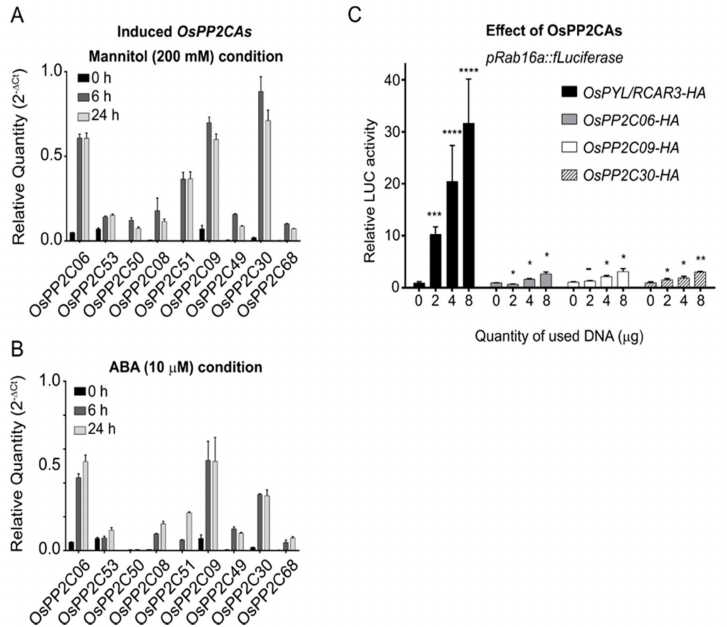
Figure 2. Highly expressed PP2CAs in the A30 line activate transcription from the Rab16A promoter. ( A , B ), relative transcript levels of 9 PP2CA genes after exposure of A30 seedlings to 200 mM Mannitol or 10 µ M ABA for 0, 6, or 24 h. All values were determined by RT-qPCR and normalized to UBIQUTIN5 levels. Error bars are means ± SD ( n = 3). Similar results were obtained in three iterations. ( C ), Effects associated with overexpression of selected OsPP2C genes on Rab16 promoter activity ( pRab16A:fLUC and pUbi:rLUC ) introduced into rice protoplasts by PEG transfection. After a 15 h incubation, luciferase activities were detected. All values were normalized to luciferase activity with 0 µ g of OsPP2C overexpression vector. Error bars are means ± SD ( n = 3). One-way ANOVAs were performed with comparing to each 0 µ g (****: p < 0.0001, ***: p < 0.001, **: p < 0.01, *: p < 0.05, -: not